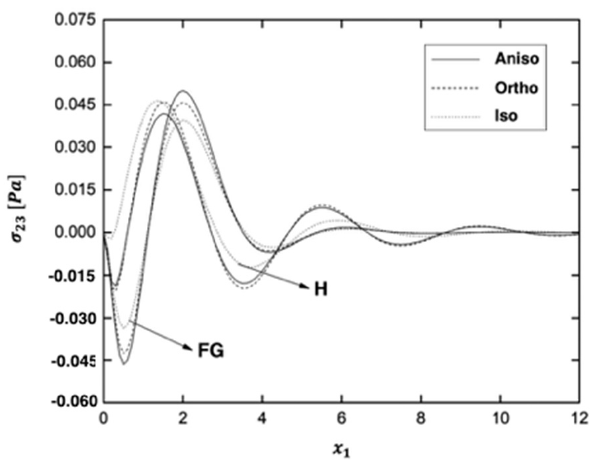
Figure 12. Variation of the thermal stress wave σ 23 along x 1 − axis in the functionally graded (FG) and homogeneous (H) fiber-reinforced plates for different materials.